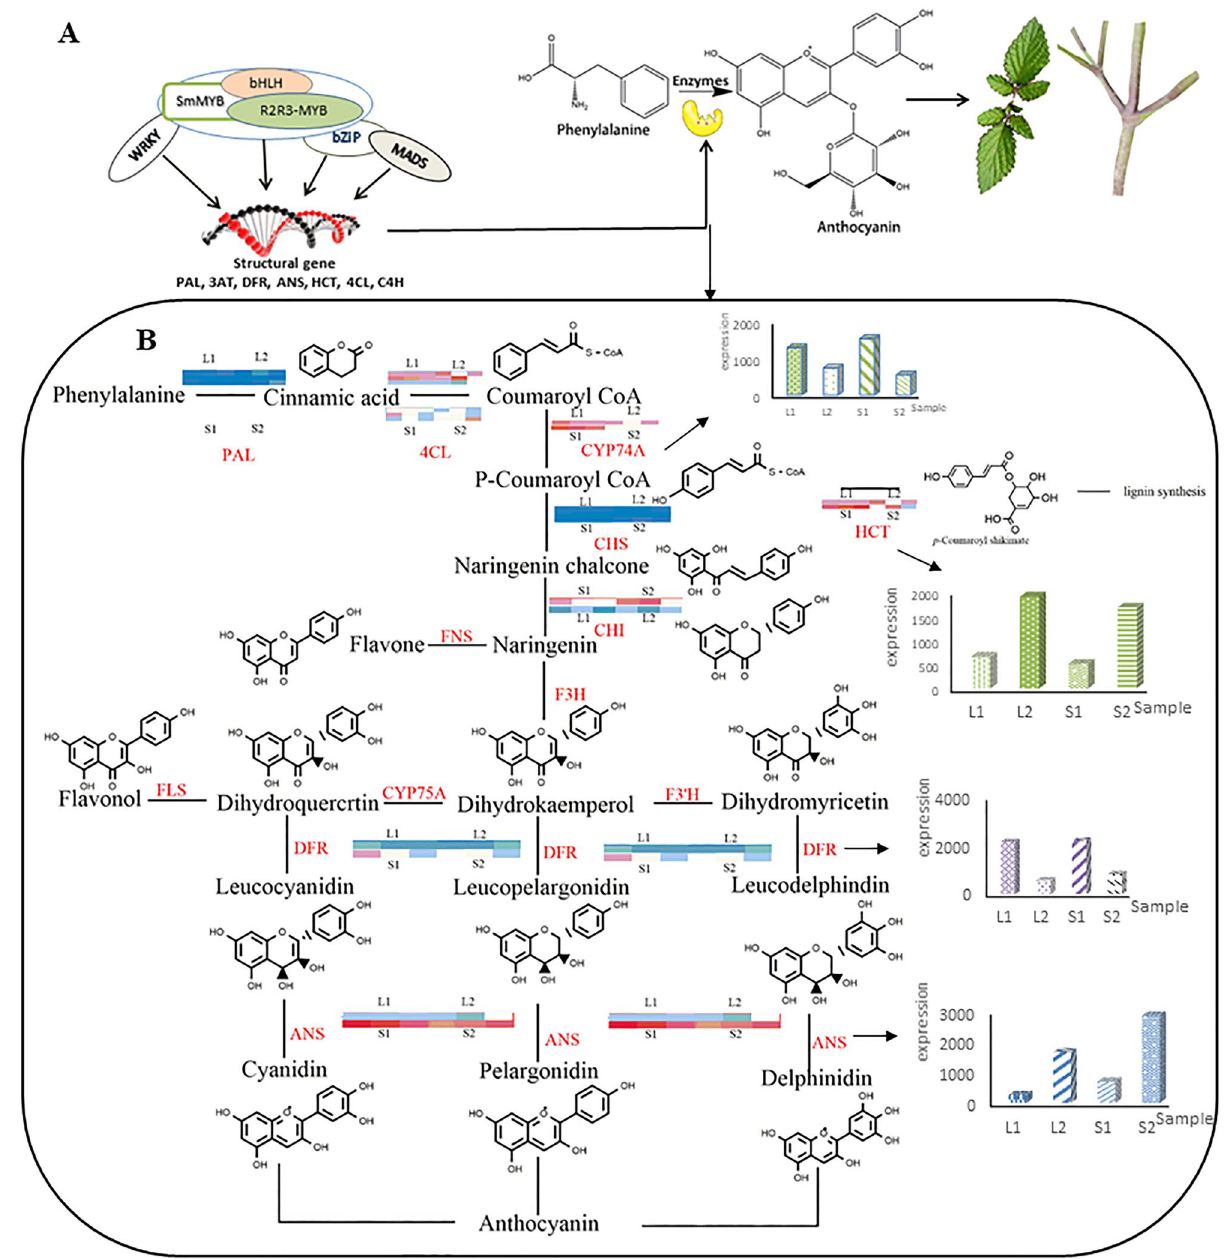
Figure 6. Molecular regulation of color phenotype characters of S. miltiorrhiza . (A) A working model to explain the internal mechanism of purple pigmentation in the aboveground part of S. miltiorrhiza . (B) Schematic diagram of flavonoids biosynthesis and regulation in S. miltiorrhiza . The redder the color of the color block, the higher the expression, and the bluer the color, the lower the